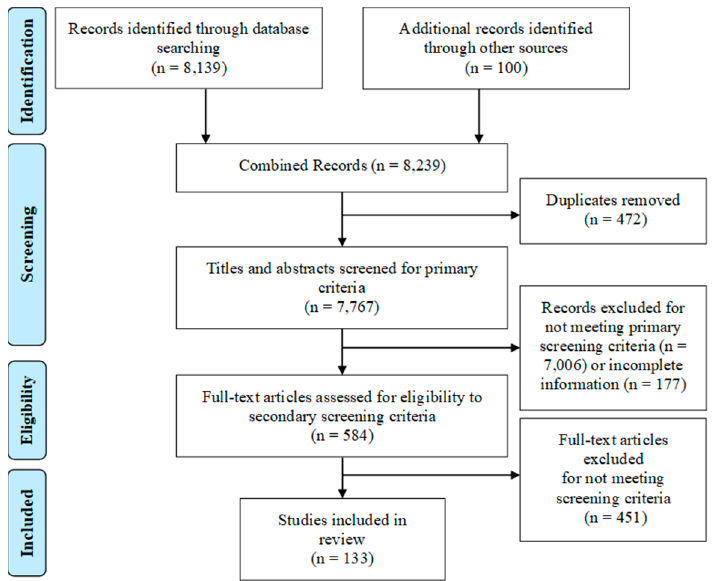
Figure 1. Preferred Reporting Items for Systematic Literature Reviews and Meta-Analyses (PRISMA) flowchart with selection of articles included in this review.